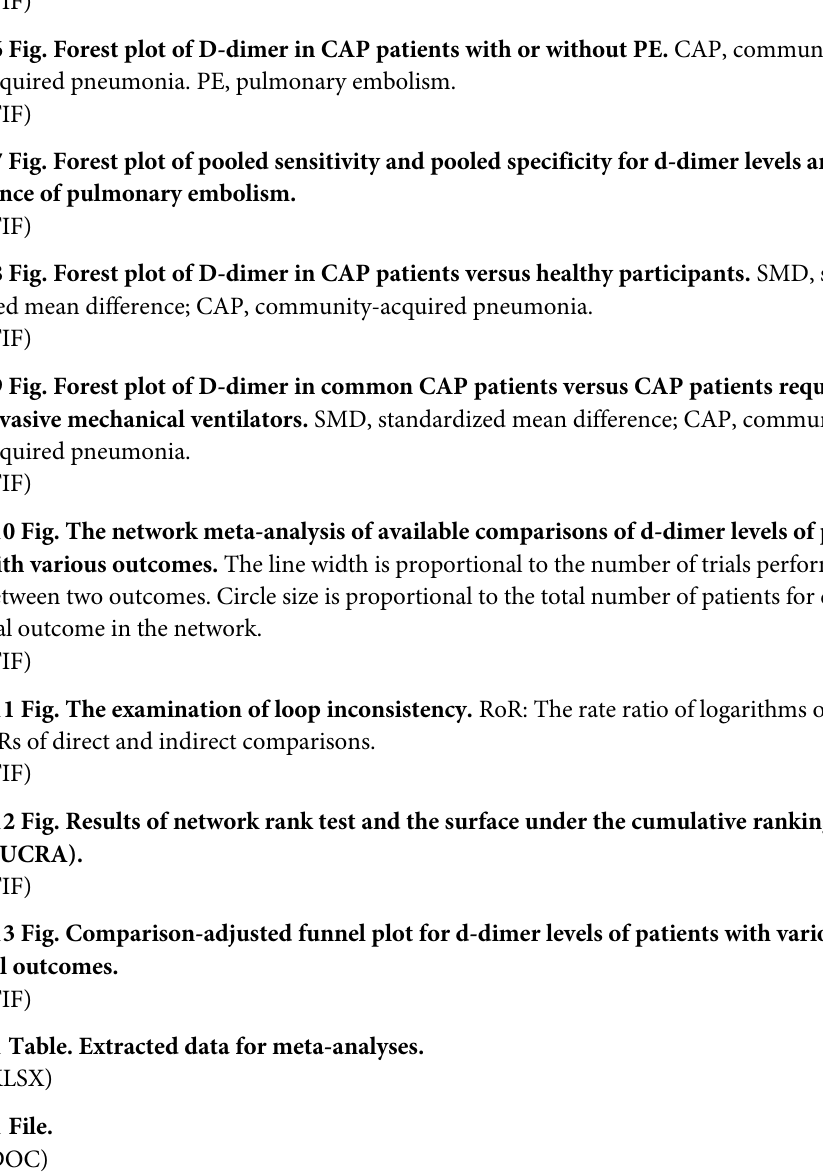
S2 Fig. Sensitivity analysis of the individual trials on the results for plasma D-dimer level associated with severity. (TIF) S3 Fig. Sensitivity analysis of the individual trials on the results for plasma D-dimer level associated with mortality. (TIF) S4 Fig. Forest plot of pooled ORs of D-dimer in survivors versus non-survivors with CAP. CAP, community-acquired pneumonia. (TIF) S5 Fig. Funnel plot with Egger’s test for association between d-dimer levels and mortality. (TIF) S6 Fig. Forest plot of D-dimer in CAP patients with or without PE. CAP, community- acquired pneumonia. PE, pulmonary embolism. (TIF) S7 Fig. Forest plot of pooled sensitivity and pooled specificity for d-dimer levels and occur- rence of pulmonary embolism. (TIF) S8 Fig. Forest plot of D-dimer in CAP patients versus healthy participants. SMD, standard- ized mean difference; CAP, community-acquired pneumonia. (TIF) S9 Fig. Forest plot of D-dimer in common CAP patients versus CAP patients requiring invasive mechanical ventilators. SMD, standardized mean difference; CAP, community- acquired pneumonia. (TIF) S10 Fig. The network meta-analysis of available comparisons of d-dimer levels of patients with various outcomes. The line width is proportional to the number of trials performed between two outcomes. Circle size is proportional to the total number of patients for each clin- ical outcome in the network. (TIF) S11 Fig. The examination of loop inconsistency. RoR: The rate ratio of logarithms of two ORs of direct and indirect comparisons. (TIF) S12 Fig. Results of network rank test and the surface under the cumulative ranking curve (SUCRA). (TIF) S13 Fig. Comparison-adjusted funnel plot for d-dimer levels of patients with various clini- cal outcomes. (TIF) S1 Table. Extracted data for meta-analyses. (XLSX) S1 File.